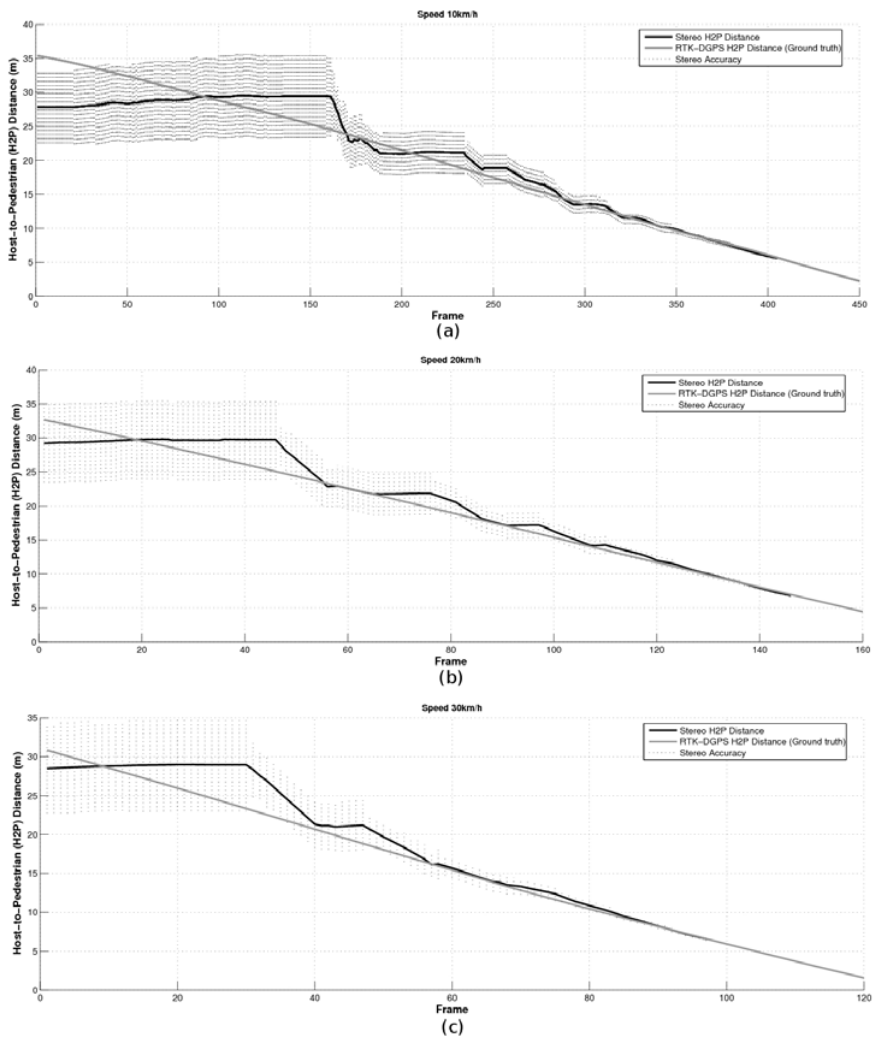
Figure 13. Stereo Host-to-Pedestrian (H2P) distance measurements and their accuracy